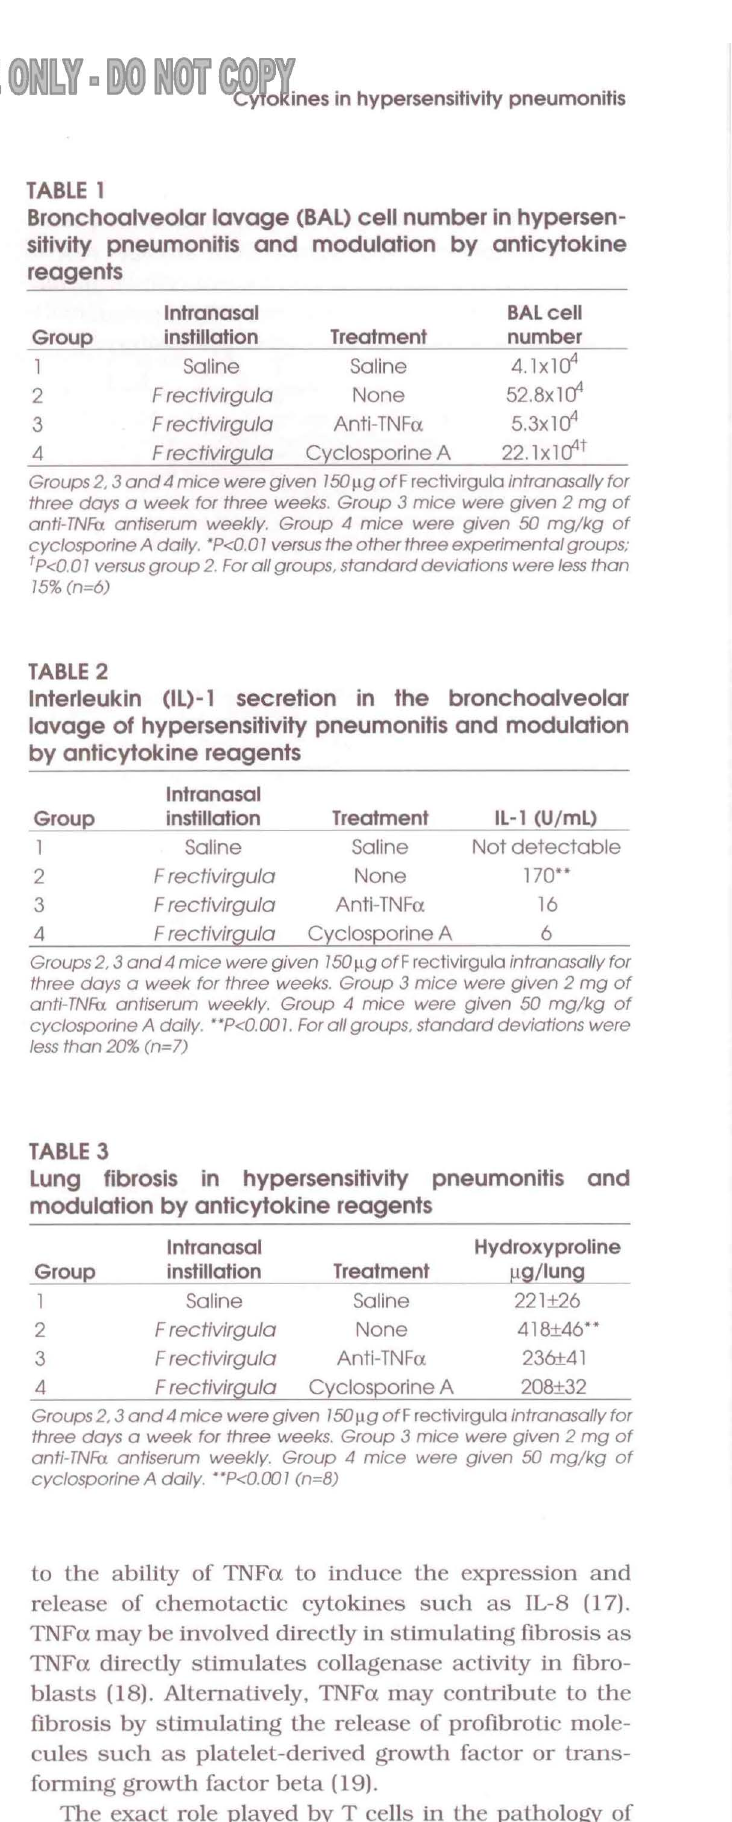
Lung fibrosis in hypersensitivity pneumonitis and modulation by anticytokine